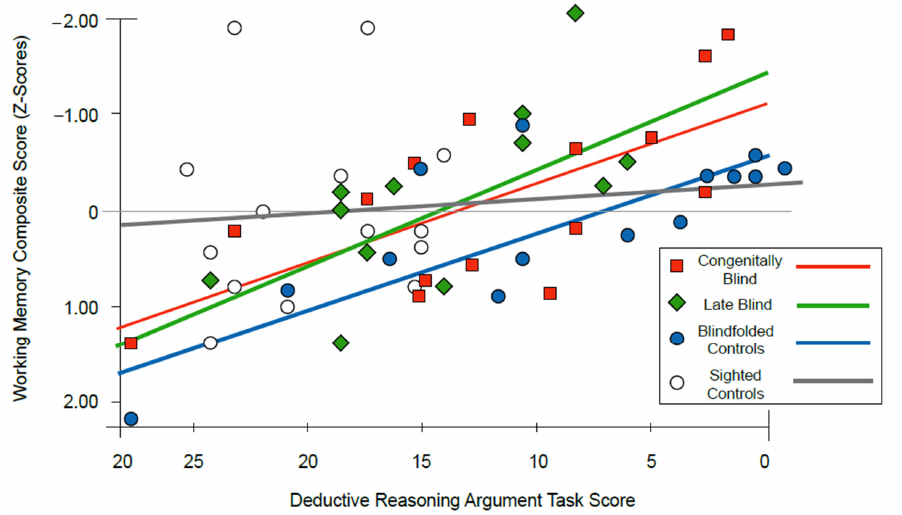
Figure 3. Correlation of reasoning and working memory tasks in the sighted, blindfolded, congeni- tal, and late blindness groups. Scatter plot showing the correlations between deductive reasoning scores ( x ) and working memory scores ( y ) for congenitally blind (red squares), late blind (green lozenges), blindfolded controls (blue circles), and sighted controls (white circles). All the correla- tions between the deductive reasoning argument task and working memory composite score were significant for all the groups, except for the sighted controls.